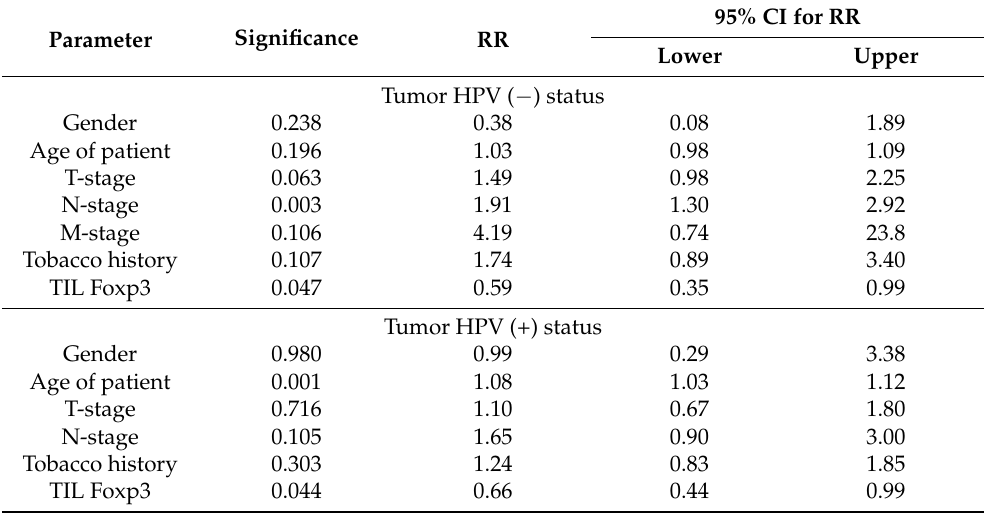
Table 3. Cox multivariate regression five-year DSS including gender at diagnosis, age, TNM stage, tumor HPV status, tobacco consumption history as well as tumor-infiltrating levels of Foxp3, CD3 or CD68 measured from HE slides scored as quartiles. Showing only indicated covariate. 95% CI for RR Covariate Significance RR Lower Upper Including gender, TNM stage, HPV status and tobacco history + TIL Foxp3 TIL Foxp3 0.002 0.61 0.44 0.83 Including gender, TNM stage, HPV status and tobacco history + TIL CD3 TIL CD3 0.460 0.80 0.44 1.45 Including gender, TNM stage, HPV status and tobacco history + TAM CD68 TAM CD68 0.058 0.54 0.28 1.02